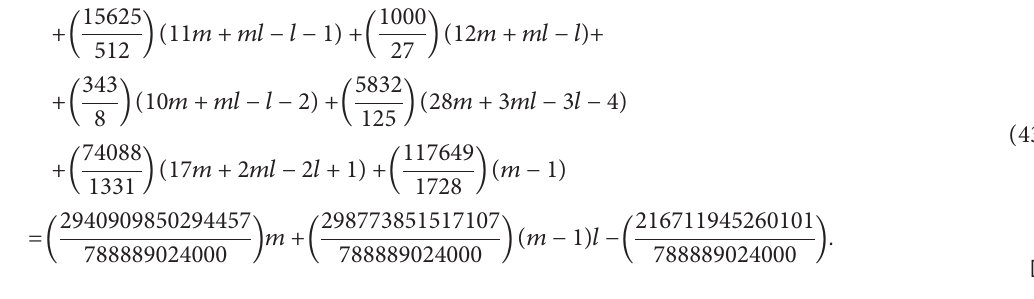
l l m , GL m , and AM m using Sanskruti and augmented Zagreb indices. (a) 3D graphs of the first SI. (b) 3D graphs